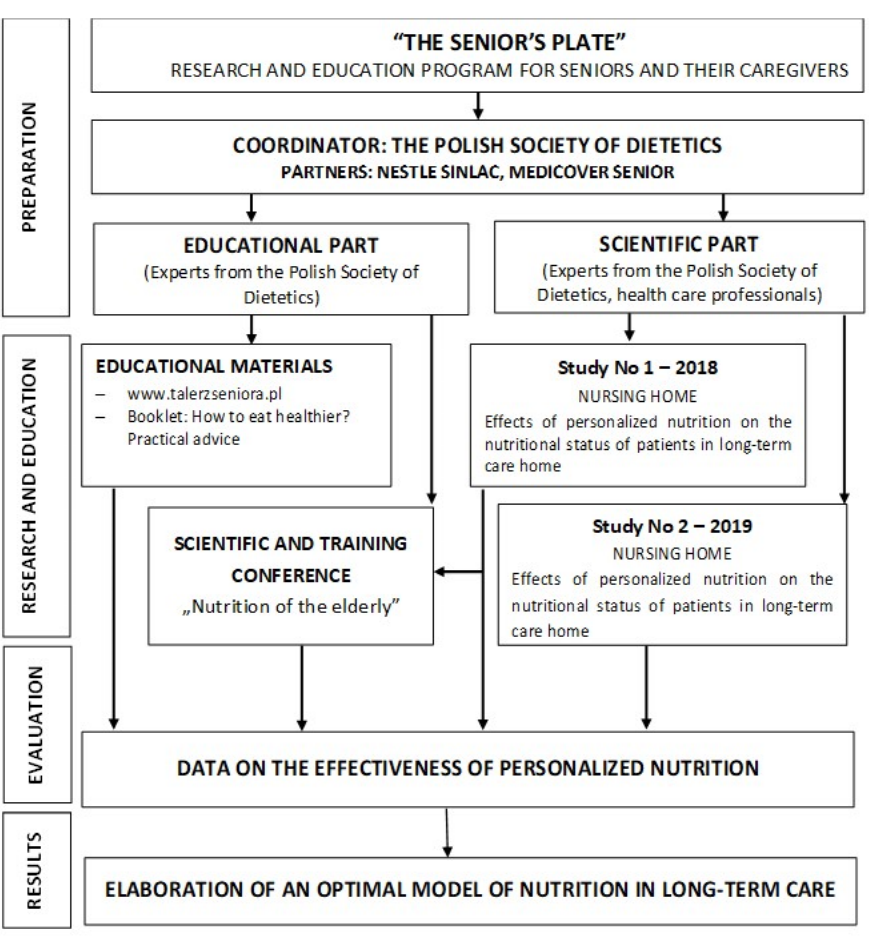
Figure 1. The Senior’s Plate Project design.